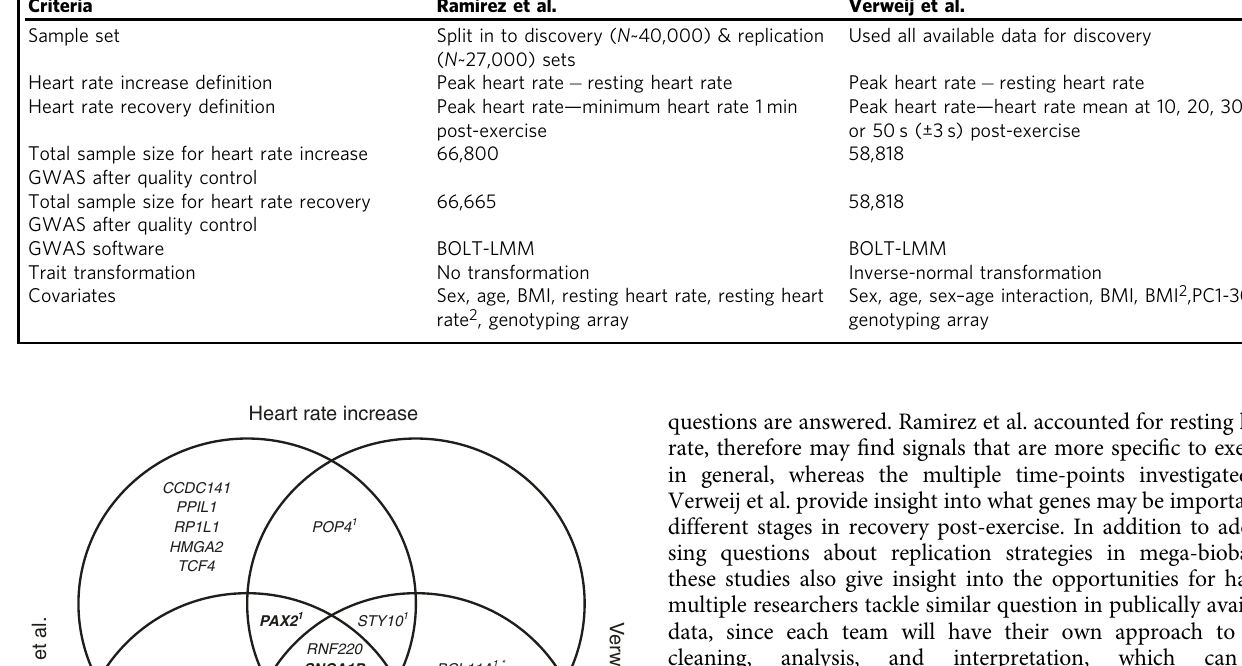
Table 1 Methodology comparison between Ramirez et al. and Verweij et al. for genetic analysis of heart rate increase and recovery in response to exercise in UK Biobank. Ramirez et